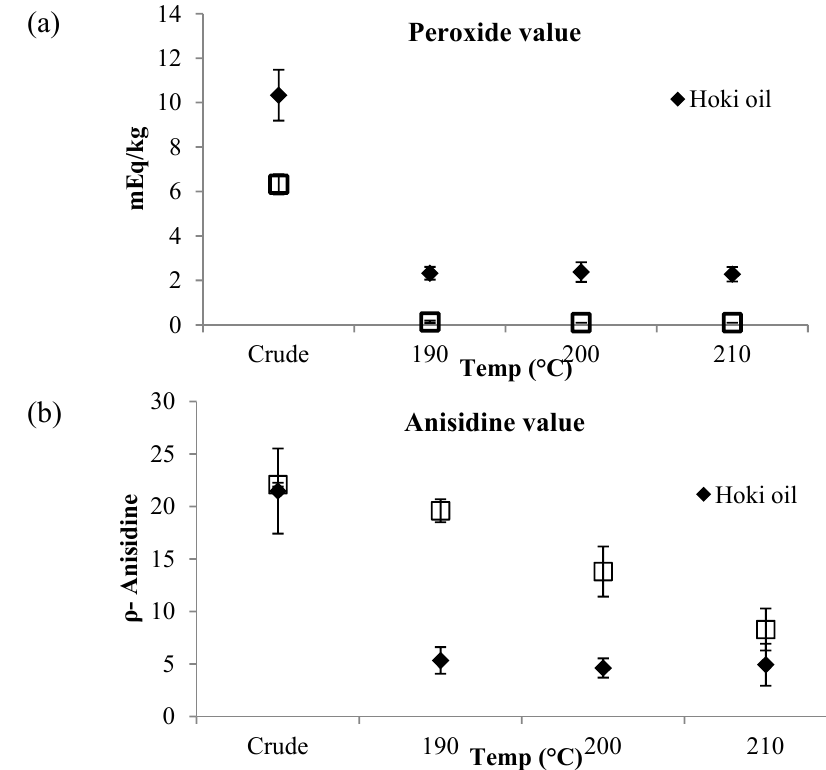
Figure 2. Quality indices of crude pollock ( n = 3) and hoki ( n = 3) oils, purified by short path distillation with variable evaporator temperatures (190 °C, 200 °C and 210 °C). ( a ) Peroxide Values; ( b ) para -Anisidine Values; ( c ) TOTOX Values; and ( d ) free fatty acids (FFA)